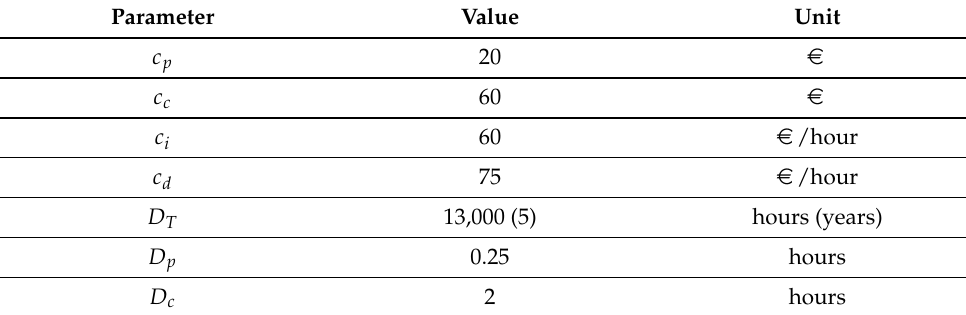
Table 2. Main characteristics of the eye blink